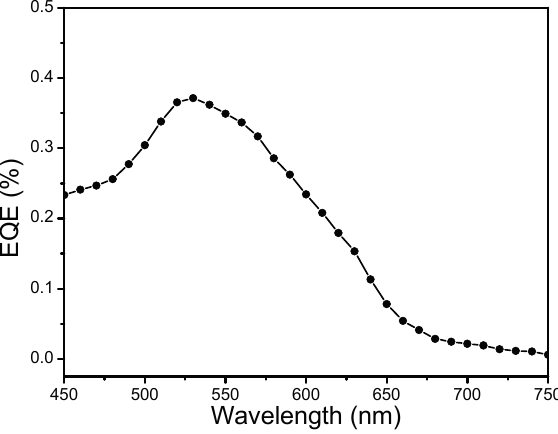
Figure 8. EQE spectrum of the ITO/PEDOT:PSS/PFO-DBT:MEH-PPV:PC 71 BM/LiF/Al